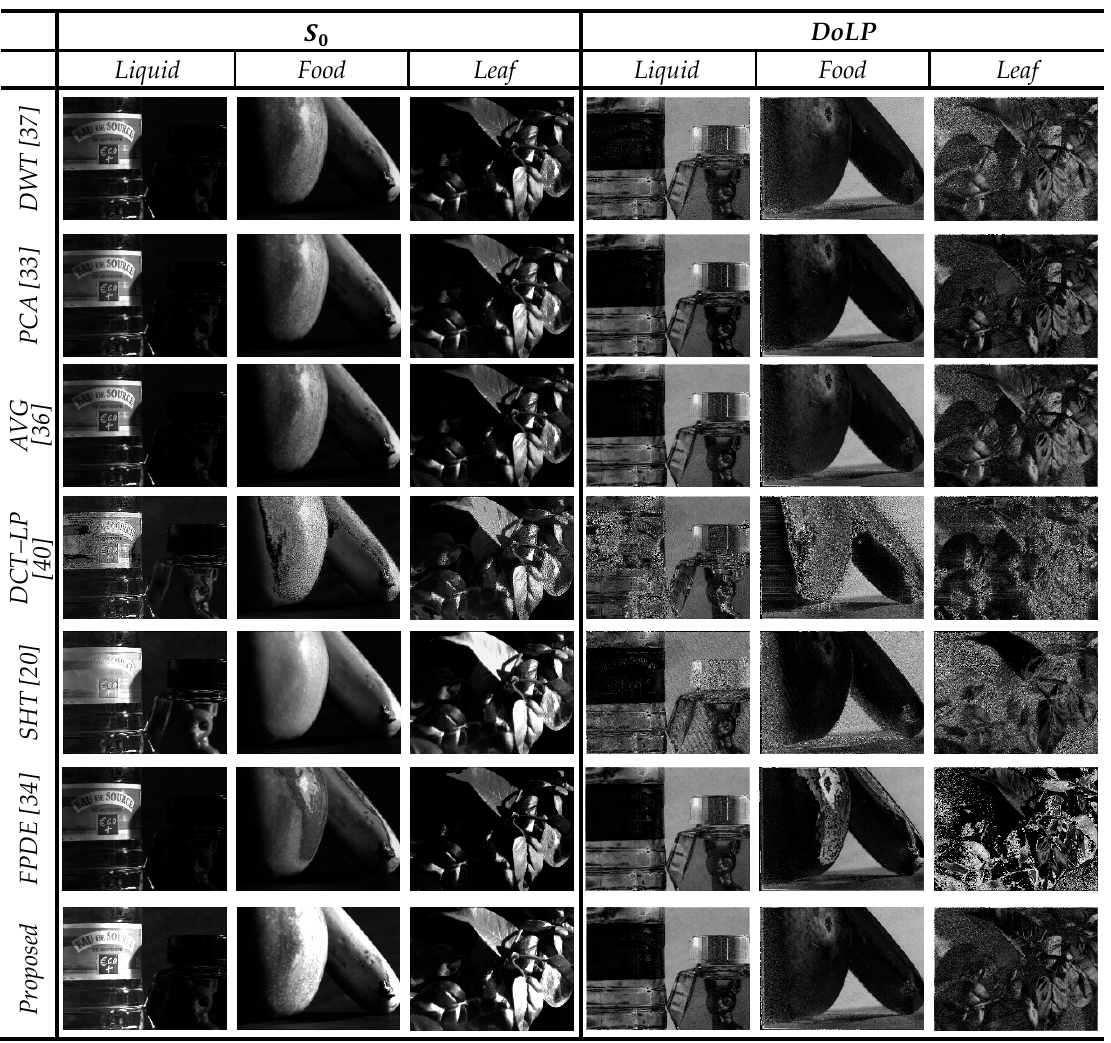
Figure 9. Polarimetric components calculated using different fusion methods.